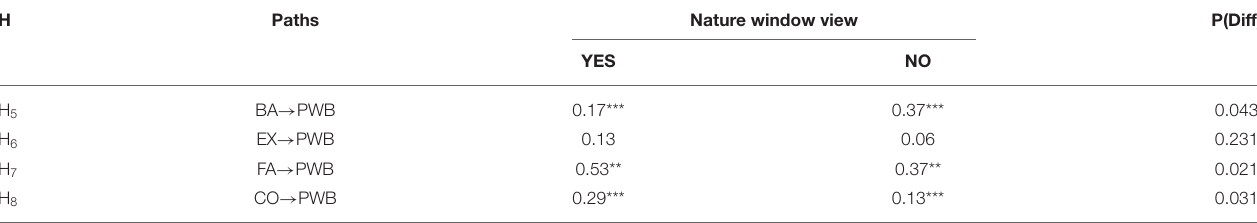
TABLE 5 | Hypotheses test by groups: nature window view vs. no nature window view [multi-group analysis (MGA)].